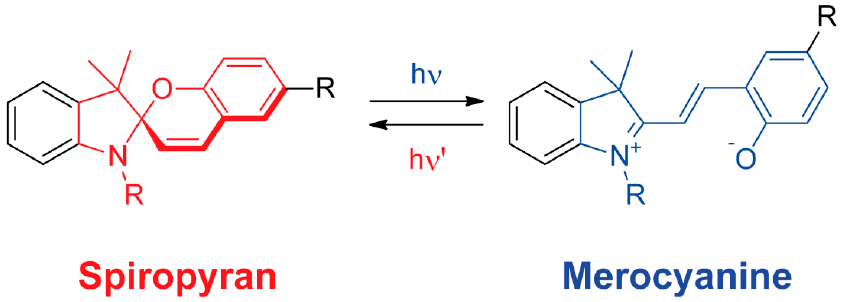
Figure 8. Reversible photoisomerization of a spiropyran compound (shown in red) to a merocyanine derivative (shown in blue).